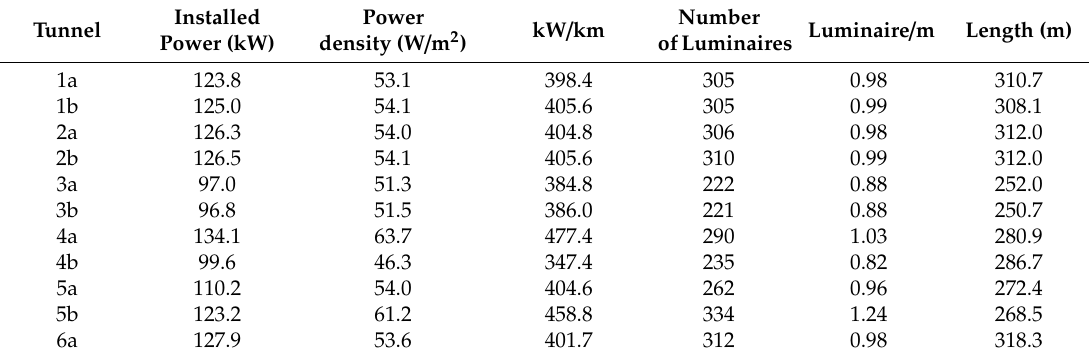
Table 2. Installed power and the corresponding energy indicators for the entrance zone of the examined tunnels.